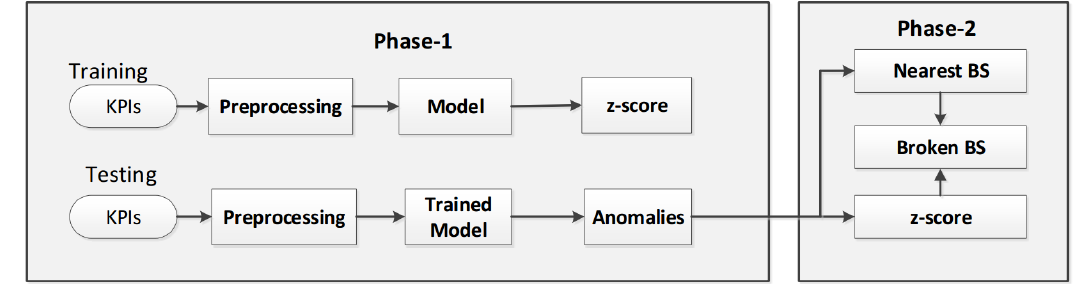
Figure 3. The cell outage detection framework based on the autoencoder model.